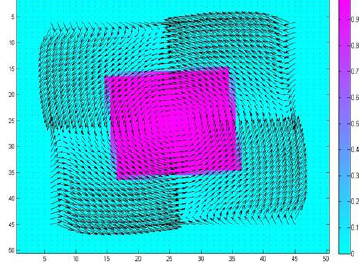
Figure 17. Results of Lucas and Kanade (Win=5, Sigma=0.5)